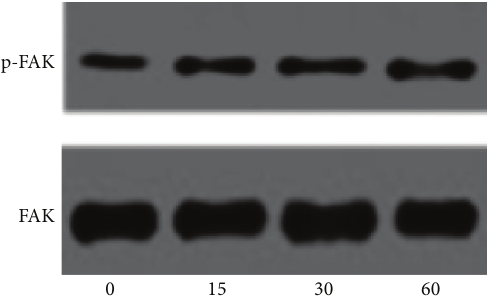
Figure 6: PC3 cells, untreated (0) or treated with CXCL12 (200 ng/mL), were lysed and then cell lysates were analyzed by immunoblotting with anti-tyrosine-phosphorylated site-specific antibody against FAK. The total protein was detected by probing the blots with anti-FAK (bottom panel). The blot was performed three times and a representative one is shown.